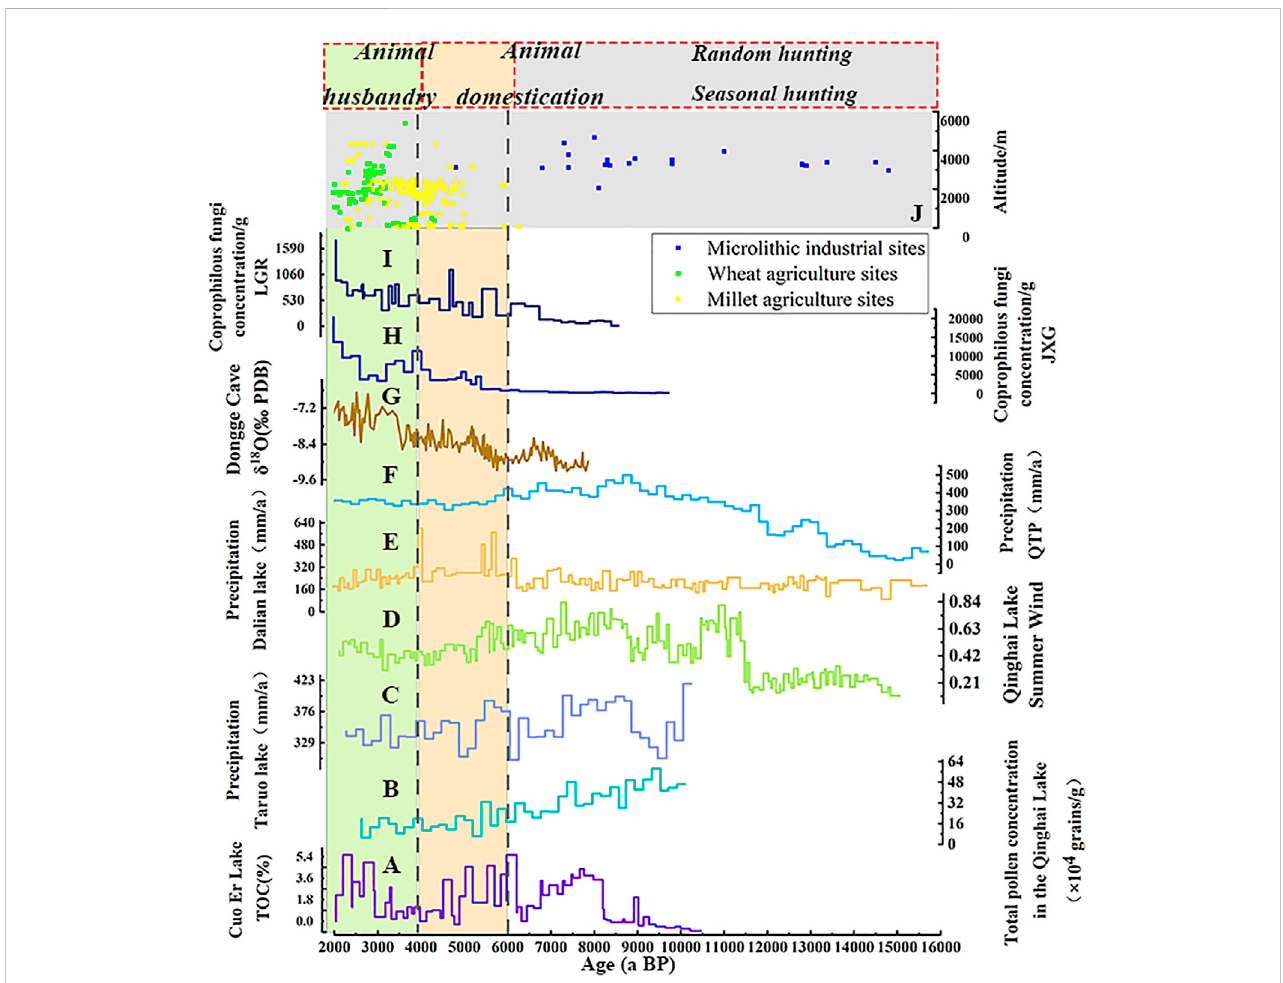
FIGURE 9 Comparison ofPaleolithic – BronzeAgeactivitiesandvariousindicatorsofenvironmentalchangeontheQinghai-TibetanPlateau(QTP) (A) Totalorganic carbon (TOC) (%) in the sedimentary record at Cuo Er Lake, central QTP (Wu et al., 2006); (B) Total pollen concentration in Qinghai Lake, northeastern QTP (×104grains/g)(Shenetal.,2005); (C) Integrated precipitationcurveinTaruolake,southwestQTP(Maetal.,2014); (D) QinghaiLakesummermonsoonindex, northeasternQTP(Anetal.,2012); (E) Quanti fi edreconstructionofrainfallinDalianLake(Chengetal.,2010); (F) Syntheticreconstructionofrainfalltrend for the QTP (Hou et al., 2012); (G) Record of monsoon intensity from Dongge cave (Dykoski et al., 2005); (H) Total coprophilous fungi concentration curve at Jiangxi Gou 2(JXG) site, Qinghai Lake Basin, northeastern QTP (Weietal., 2020a); (I) Total coprophilous fungi concentration curveat Langgeri (LGR), Qinghai LakeBasin,northeasternQTP(Weietal.,2020b). (J)